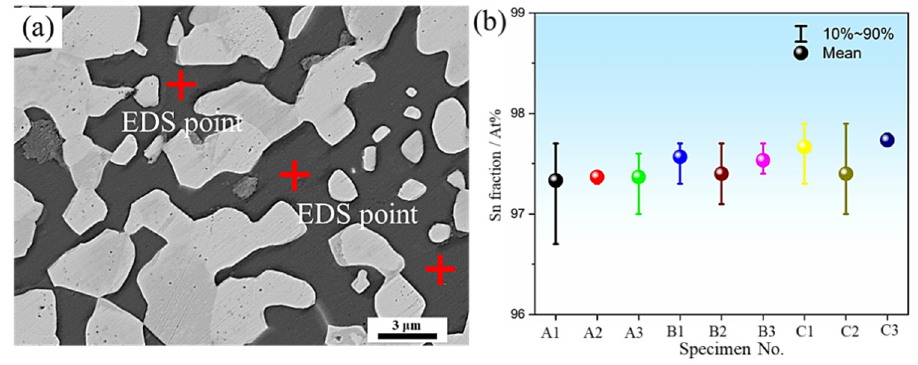
Figure 7. The EDS points measurement in β -Sn matrix of printed Sn58Bi specimens: ( a ) measurement locations, ( b ) Sn fraction.